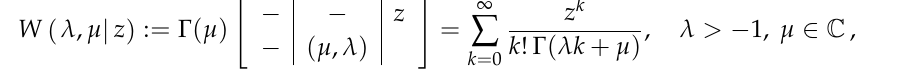
Kiryakova [5]. These multiple integrals can be denoted as generalized fractional differeitegrals [6], however this line of representation is superfluous to the necessities of the numerical (i.e. physical) modeling.